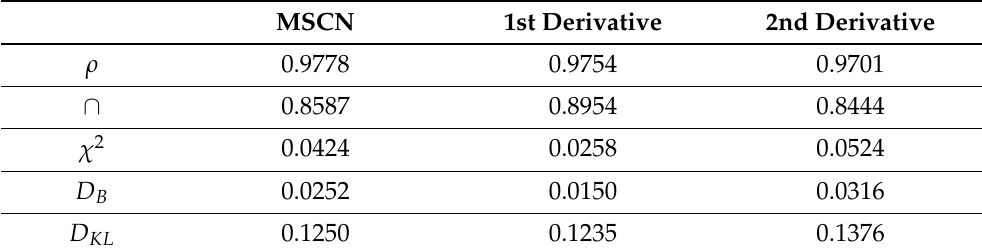
Table 3. Averaged scores from three filtered images in Figure 2. Similar to the gradients, the scores of the correlation coefficient and histogram intersection are close to unity, and the scores of the Chi-squared test, Bhattacharyya distance, and Kullback–Leibler divergence are close to